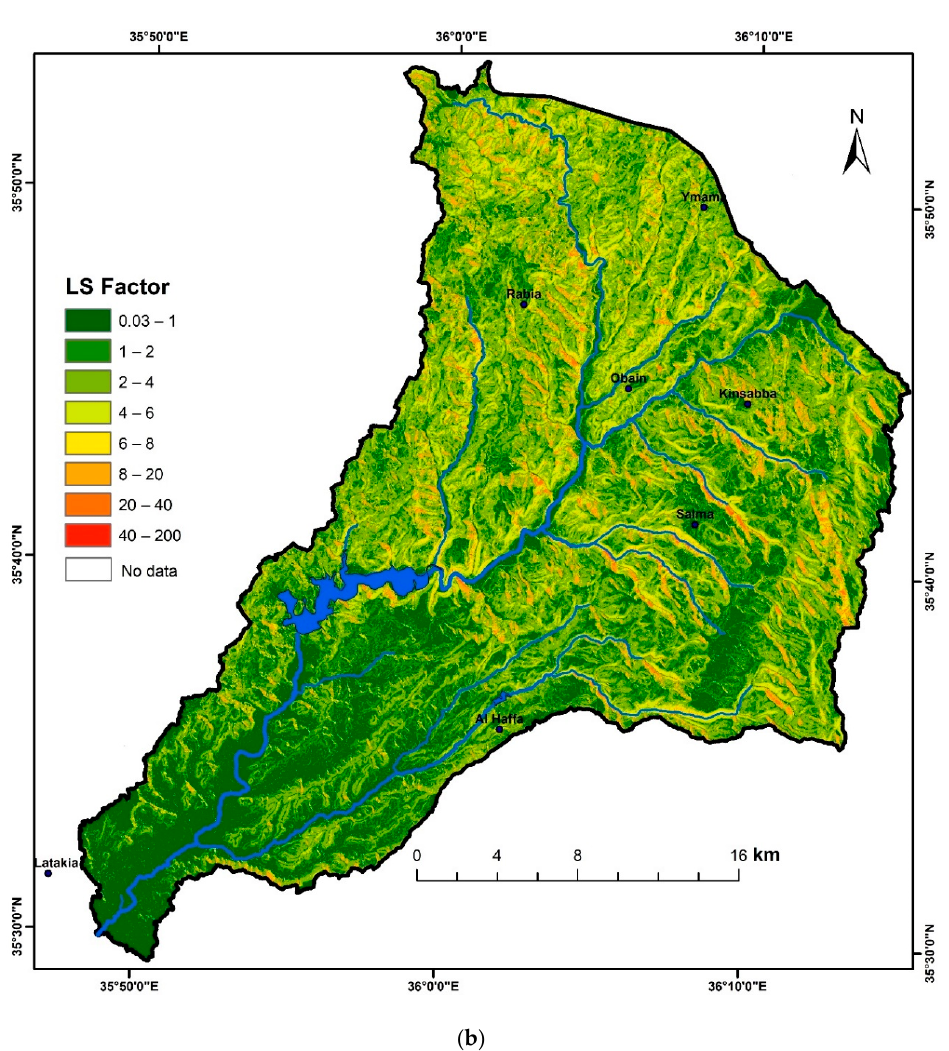
Figure 2. Factor maps of soil erosion modeling of the Northern Al ‐ Kabeer river basin. ( a ) Soil erodibility factor map; ( b ) slope length and slope steepness (LS) factor map.